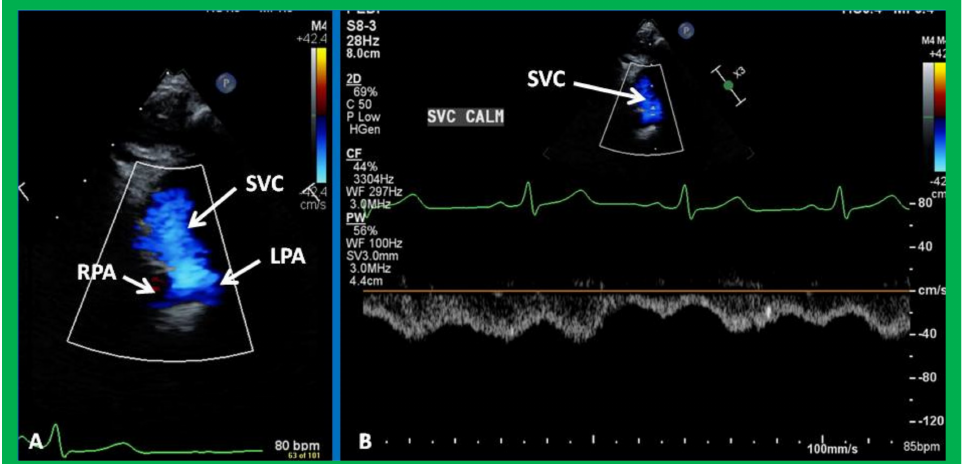
Figure 11. Echo images secured with the transducer positioned in the suprasternal notch illustrating the bidirectional Glenn shunt. Note that the superior vena cava (SVC) is draining into the right (RPA) and left (LPA) pulmonary arteries shown by color Doppler ( A ). Low Doppler flow velocities through the bidirectional Glenn shunt ( B ) indicate that the shunt is not obstructed. Reproduced from Reference [26].